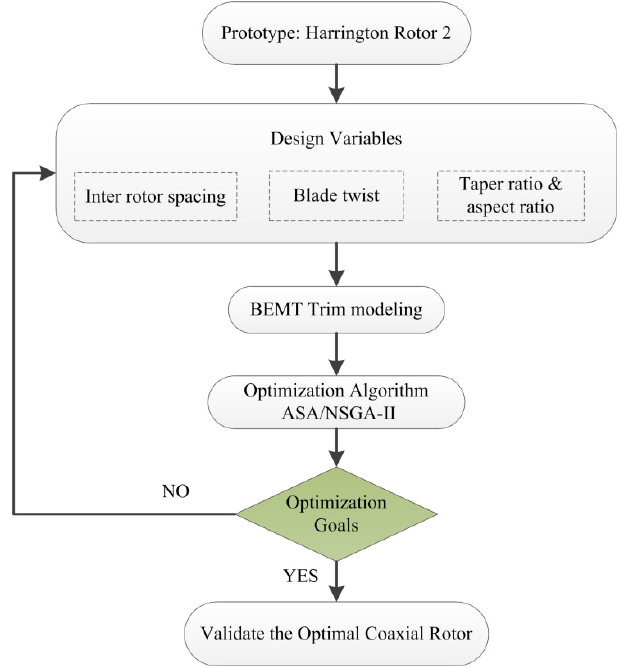
Figure 6. Framework of the optimization procedure for the mono tiltrotor (MTR) design. ASA: adaptive simulated annealing; NSGA-II: non-dominated sorting genetic algorithm II.